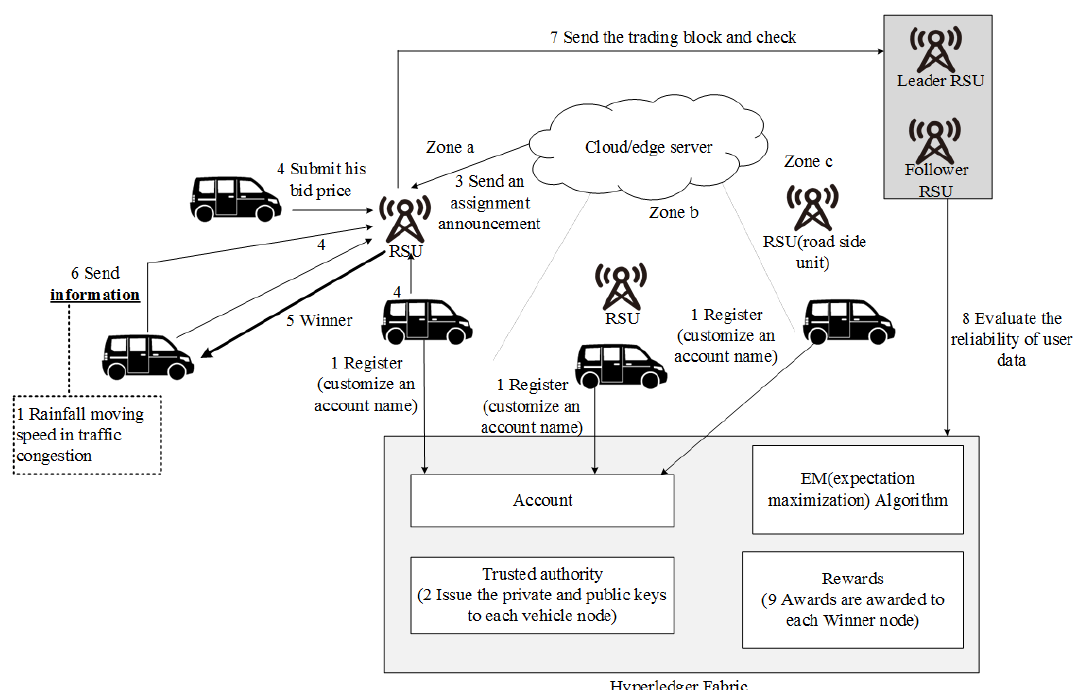
Figure 39. Reconstruction diagram of reference [71].